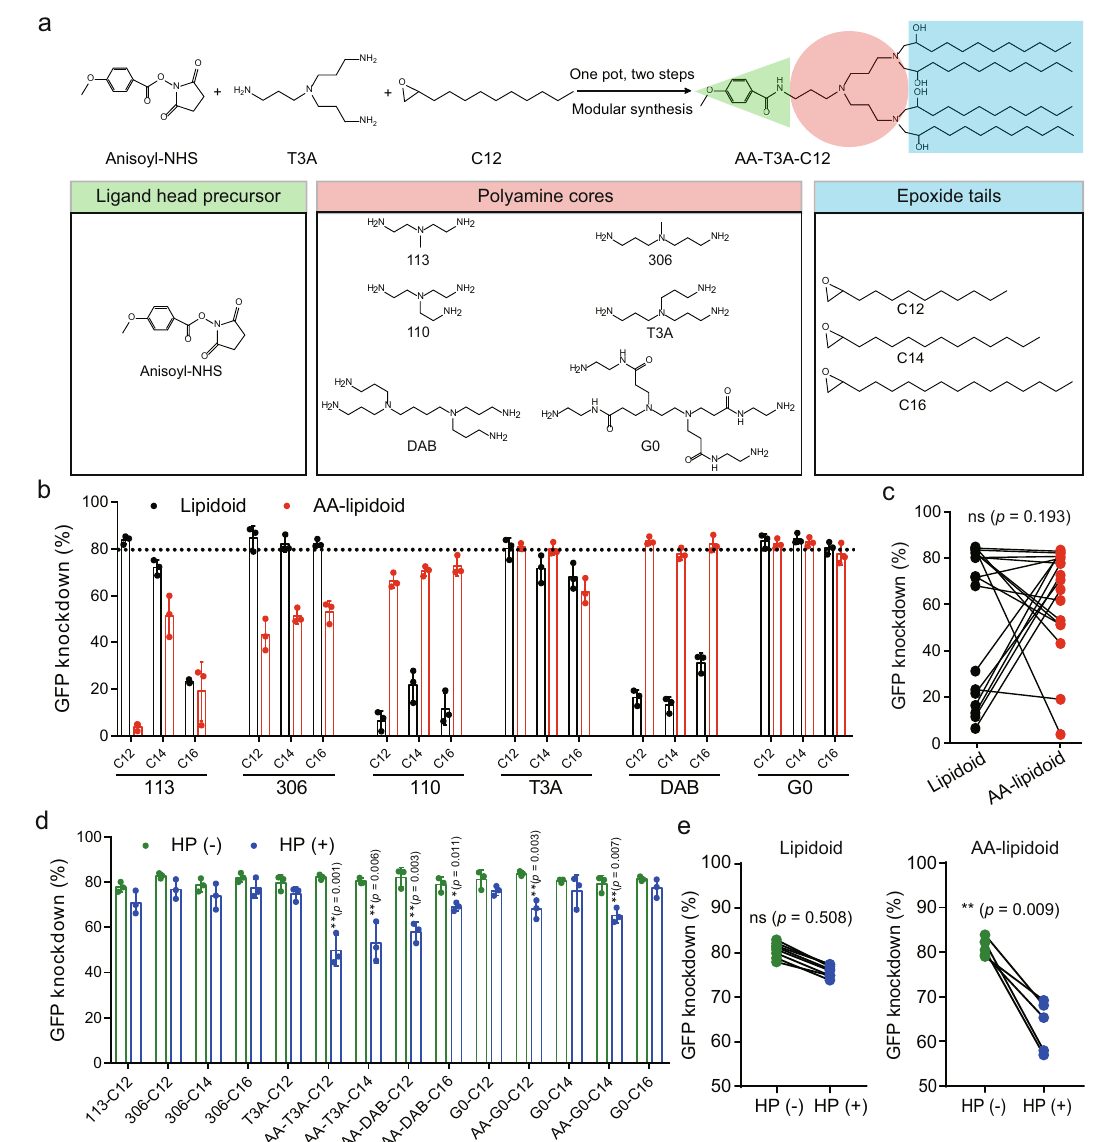
Fig. 2 | Synthesis and screening of AA-lipidoids for targeted RNA delivery to activated fi broblasts. a One-pot, two-step modular synthesis of AA-lipidoids. A representative synthesis of AA-T3A-C12 is shown. Anisoyl-NHS, polyamines, and epoxideswereusedtobuildacombinatoriallibraryof18AA-lipidoids. b First-round screening of lipidoids and AA-lipidoids with high potency ( n =3/group). Lipidoids without anisamide were synthesized by the traditional ring-opening reactions between epoxides and polyamines. GFP siRNA-loaded LNPs were formulated to treat activated 3T3-GFP fi broblasts for 48h to obtain their knockdown ef fi ciency. The dashed line indicates 80% GFP knockdown. c Statistical analysis of